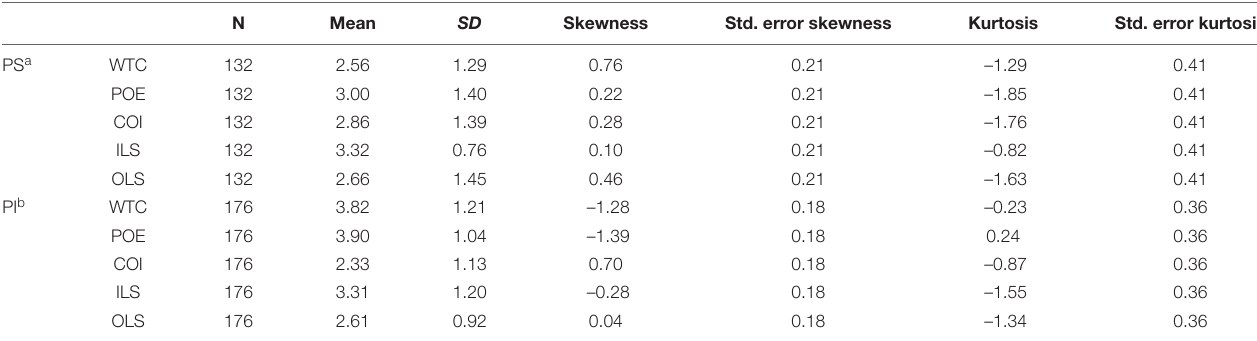
TABLE 3 | Descriptive Statistics for WTC, L2 Grit (POE and COI), and L2MSS (ILS and